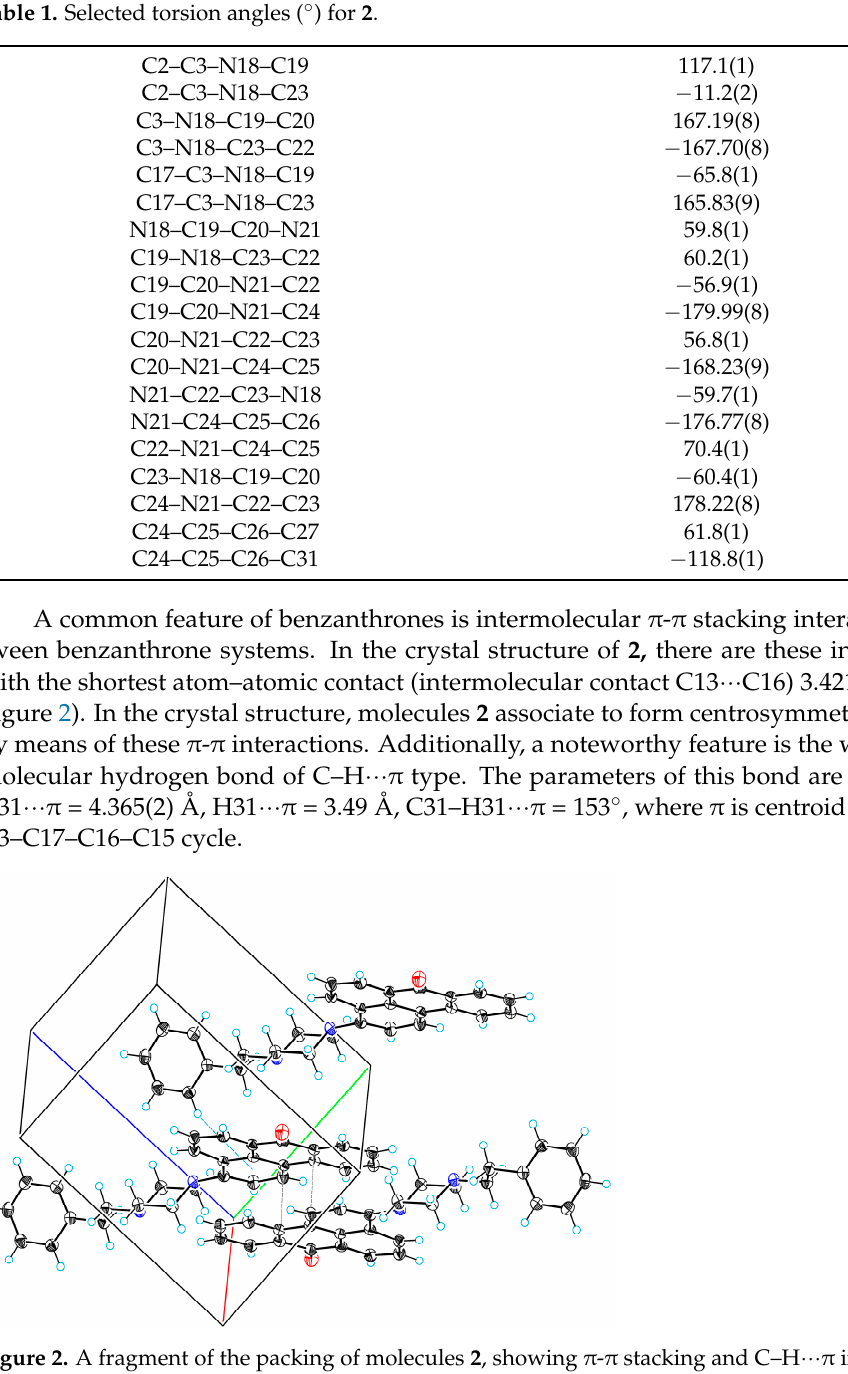
Figure 2. A fragment of the packing of molecules 2 , showing π‐π stacking and C–H ∙∙∙π interac ‐